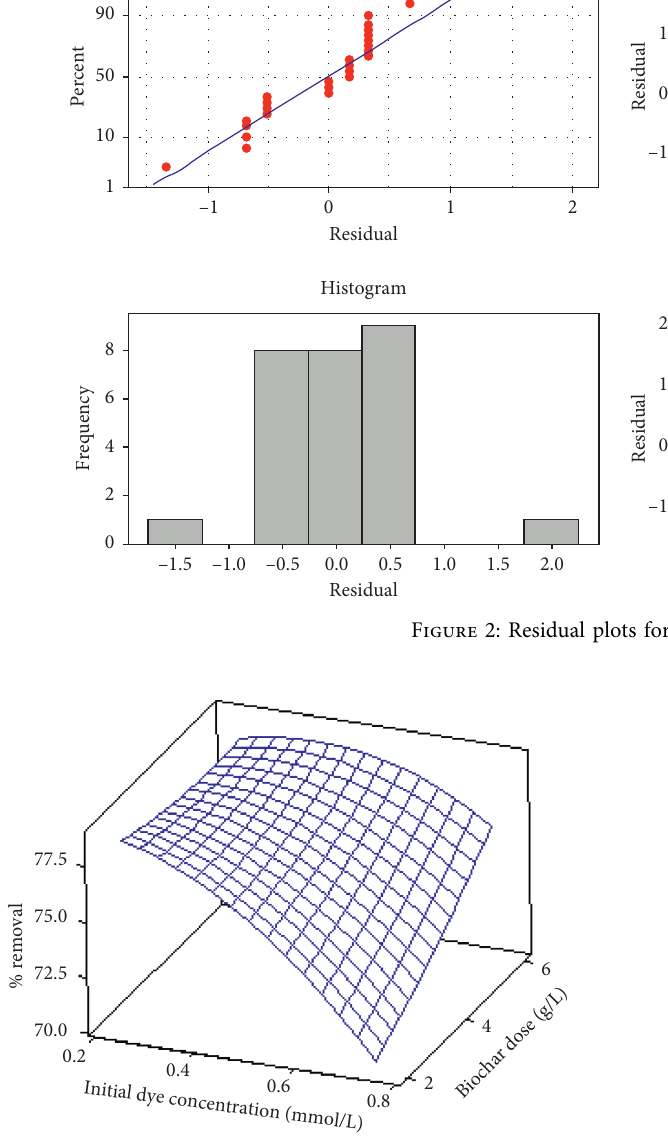
Figure 3: Effect of initial dye concentration (mmol/L) and biochar dosage (g/L).